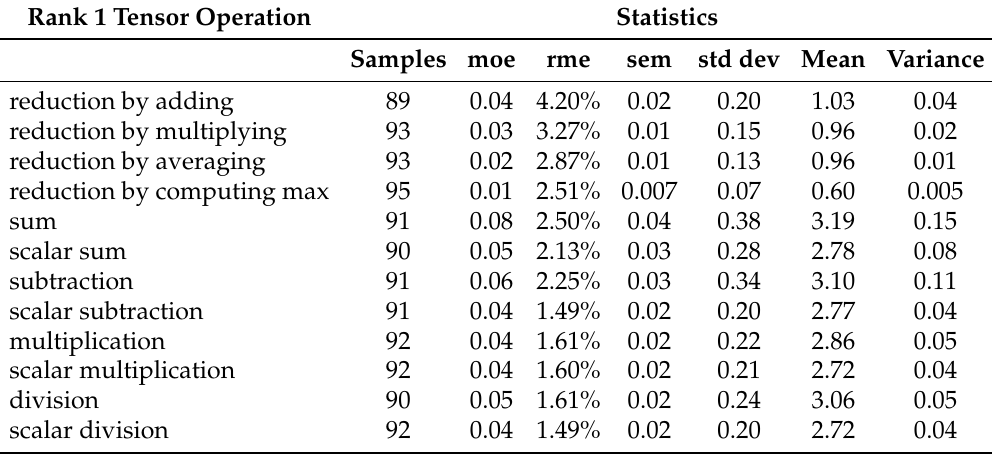
Table 19. Raspberry Pi IV benchmark statistics for rank 1 tensor operations with k = 128 (times in ms).